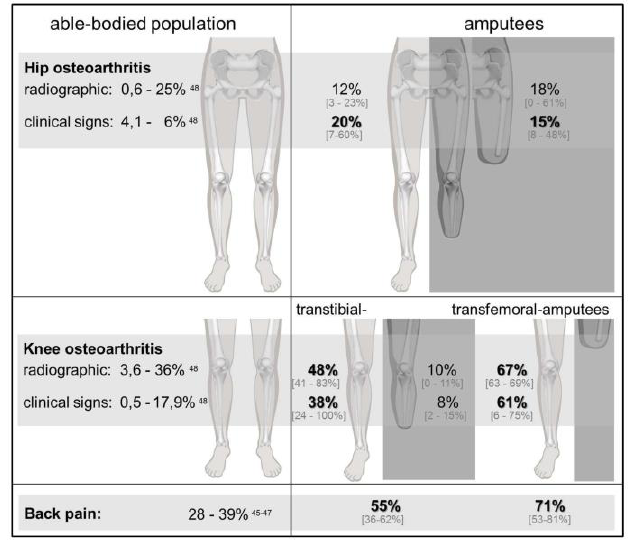
Figure 1. Quantitative summary of the prevalence of back pain and